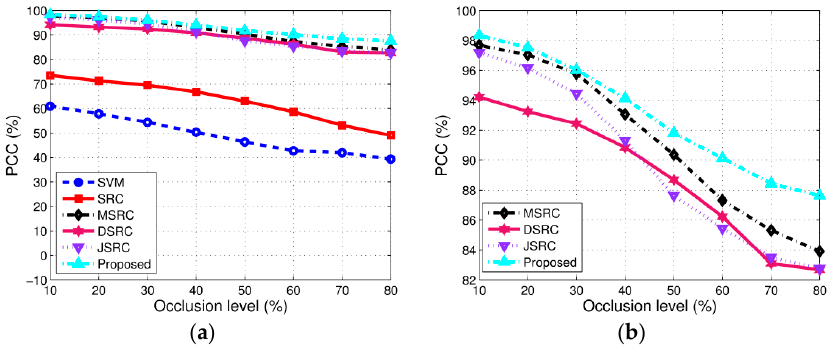
Figure 11. Performance under partial occlusion from direction 1. ( a ) Single view methods; ( b ) Multi-view methods.